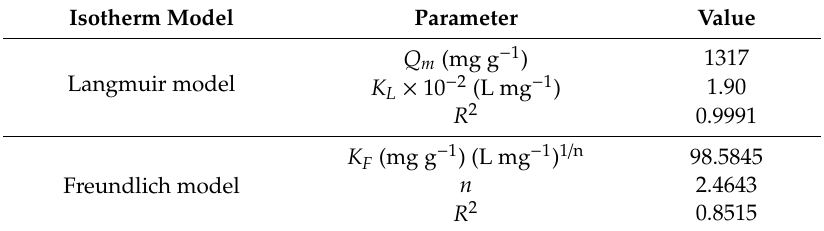
Table 1. Langmuir and Freundlich model fitting parameters for MB adsorption on